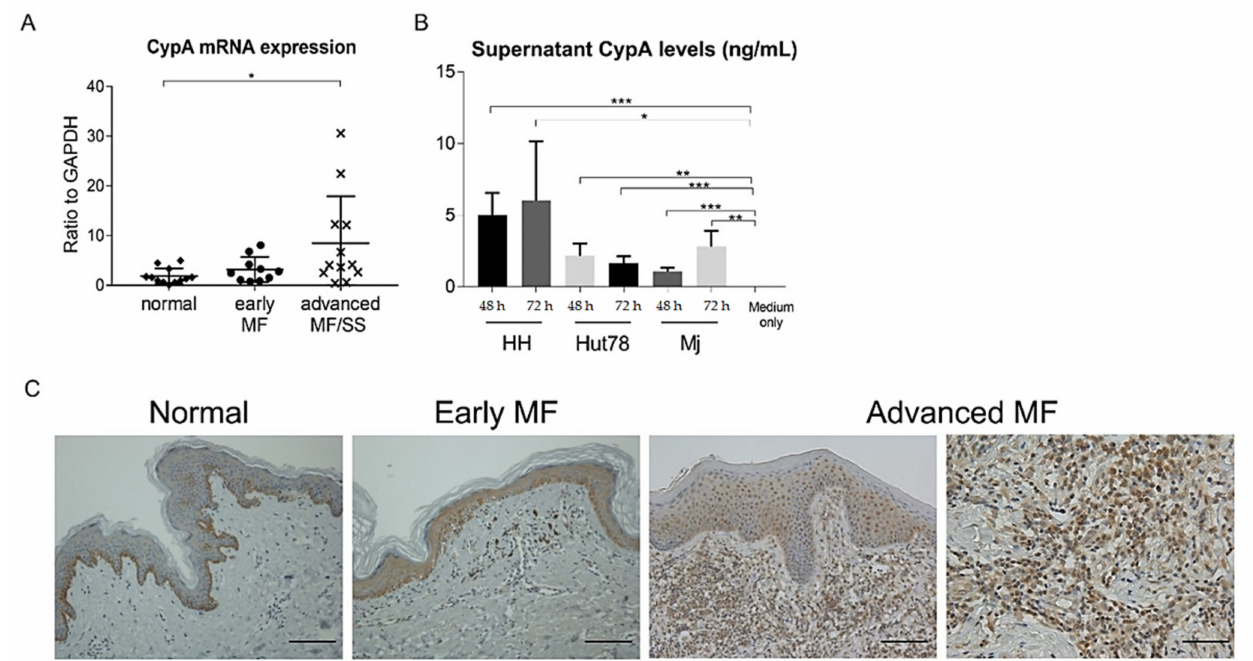
Figure 2. Cyclophilin A (CypA) is expressed on tumor cells and epidermal keratinocytes in mycosis fungoides (MF) and S é zary syndrome (SS). ( A ) Quantitative RT-PCR was performed to measure expression levels of CypA using mRNA extracted from lesional skin of early MF ( n = 10), advanced MF/SS ( n = 13), and healthy skin ( n = 12). Bars represent mean ± 2 standard deviation. ( B ) CypA staining in MF/SS lesional skin ( n = 7). Representative results are shown (original magnification × 200 in left three panels, and × 400 in the most right panel; scale bar = 50 µ m in left three panels, and 100 µ m in the right most panel. ( C ) Human cutaneous T-cell lymphoma cell lines (HH, Hut78, and MJ cells) were cultured for 24, 48, and 72 h. Supernatant CypA levels were evaluated by enzyme-linked immunosorbent assay. One representative result from two independent experiments. Data are presented as mean ± standard deviation ( n = 4). * p < 0.05, ** p < 0.01, *** p <